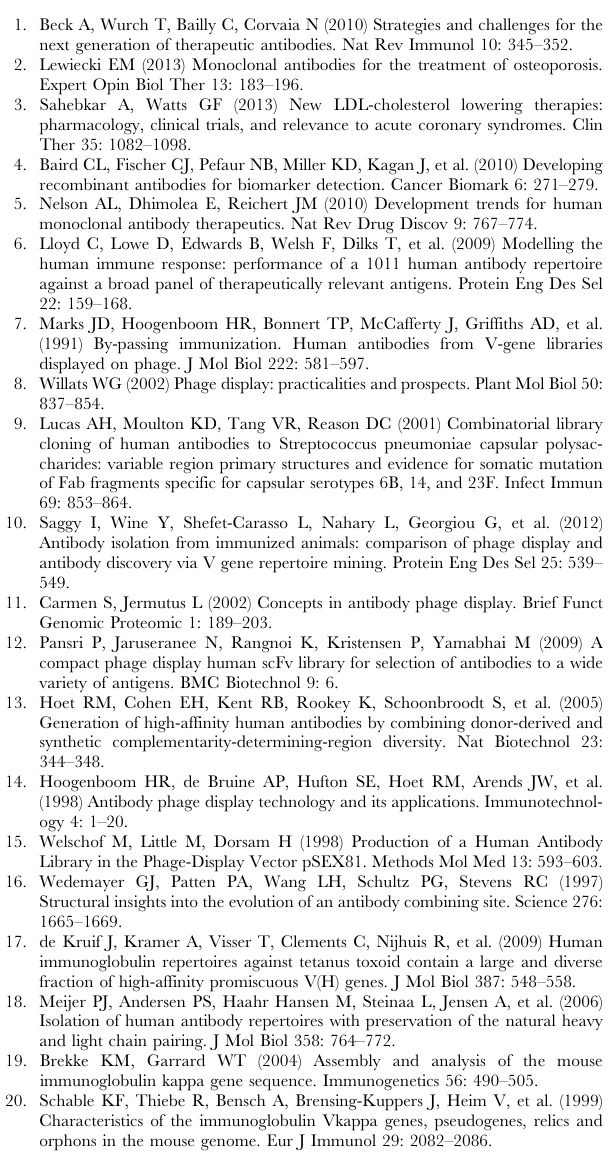
Figure S1 Representative SPR sensorgrams for mono- clonal antibody and Fab TT kinetic assays. Table S1 V k and V H Gene-Specific Primers. Table S2 Binding Kinetics of Representative TT-specif- ic Fabs from the Phage Display Library.